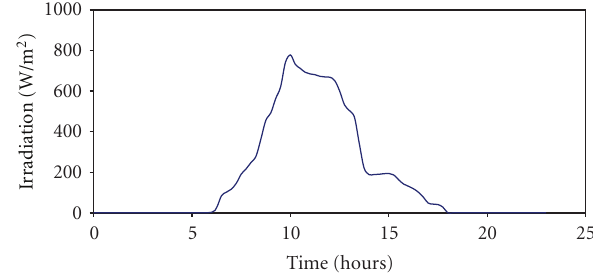
Figure 3: Solar irradiation for the selected day (November 19, 2009).